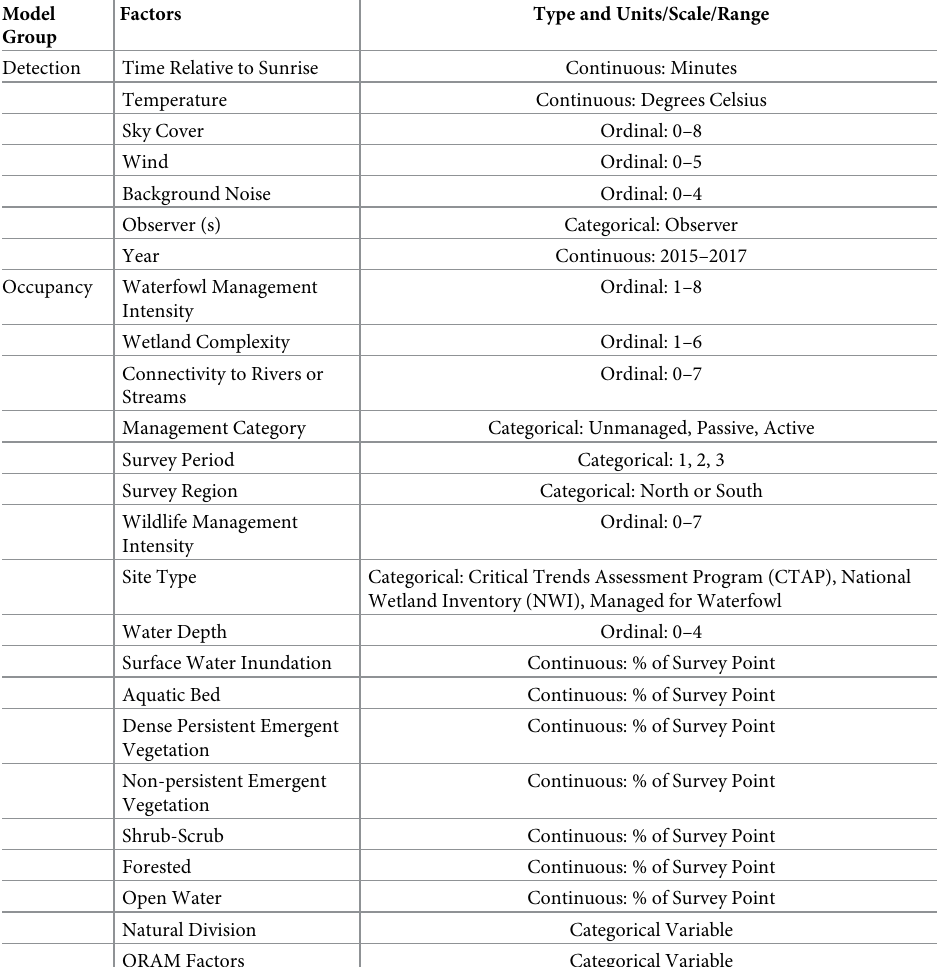
Table 1. List of factors and the corresponding units used as possible predictors of marsh bird detection and abun- dance in Illinois during late spring and early summer